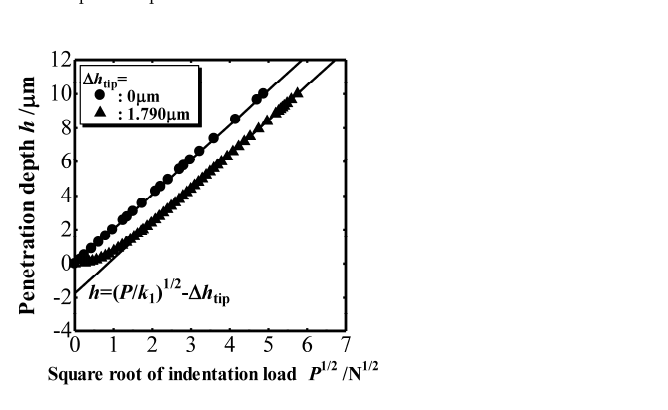
Figure A5. Penetration depth h vs. square root of indentation load P *** obtained with truncated indenters.